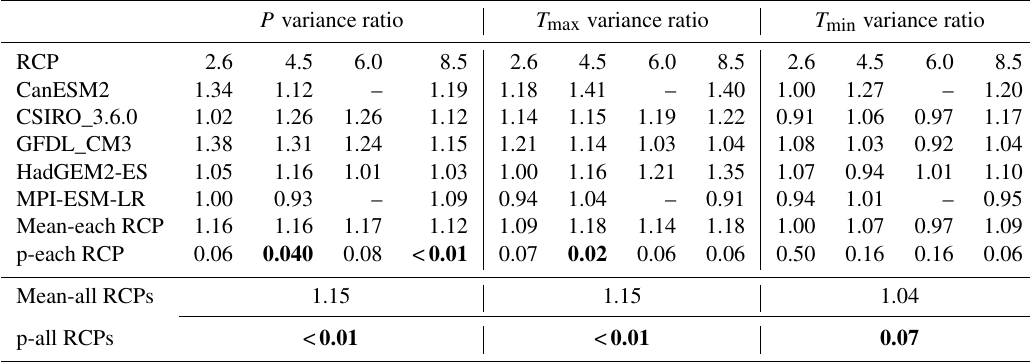
Table 3. Variance ratios of precipitation and temperature during 2011–2040 relative to 1961–2005. P variance ratio